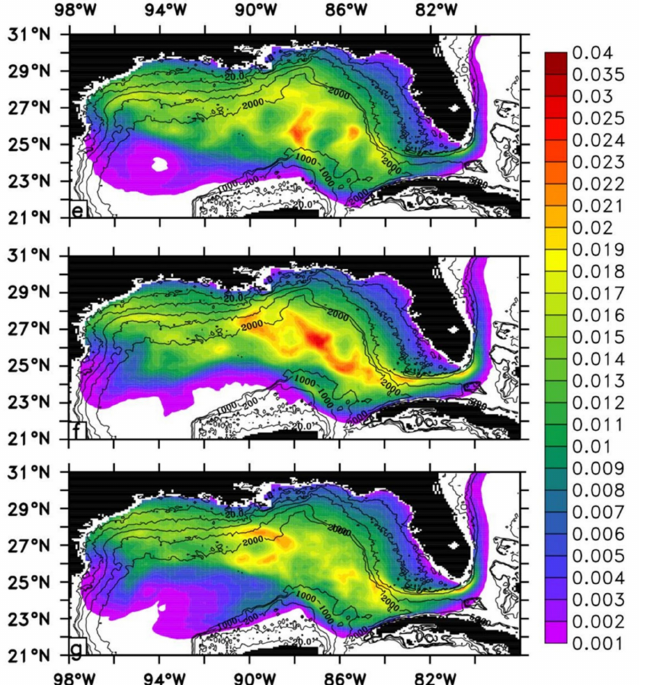
Figure 4. Annual conditional probability at day 30 in ( a ) 2000, ( b ) 2001, ( c ) 2002, ( d ) 2003, ( e ) 2004, ( f ) 2005, and ( g ) 2006. The interval on the color bar is 0.001 from 0.001 to 0.025, and the interval is 0.005 for 0.025 and above. Black lines denote isobaths of 20, 50, 200, 1000, and 2000 m